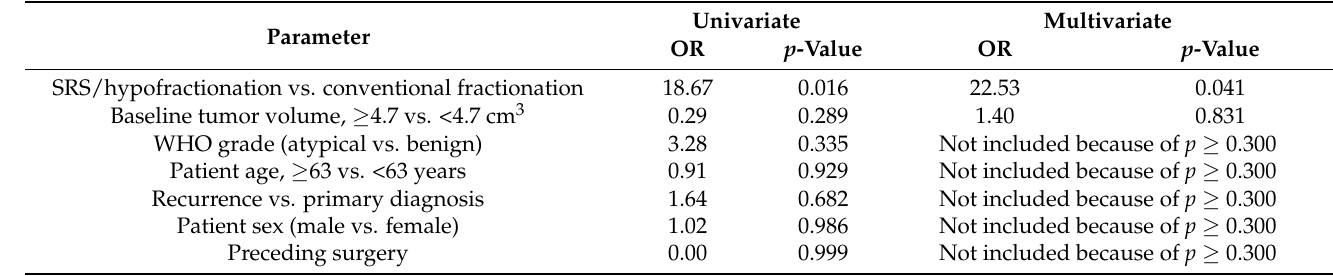
Table 2. Logistic regression analysis of predictive factors for pseudoprogression/transient enlarge- ment ( n =